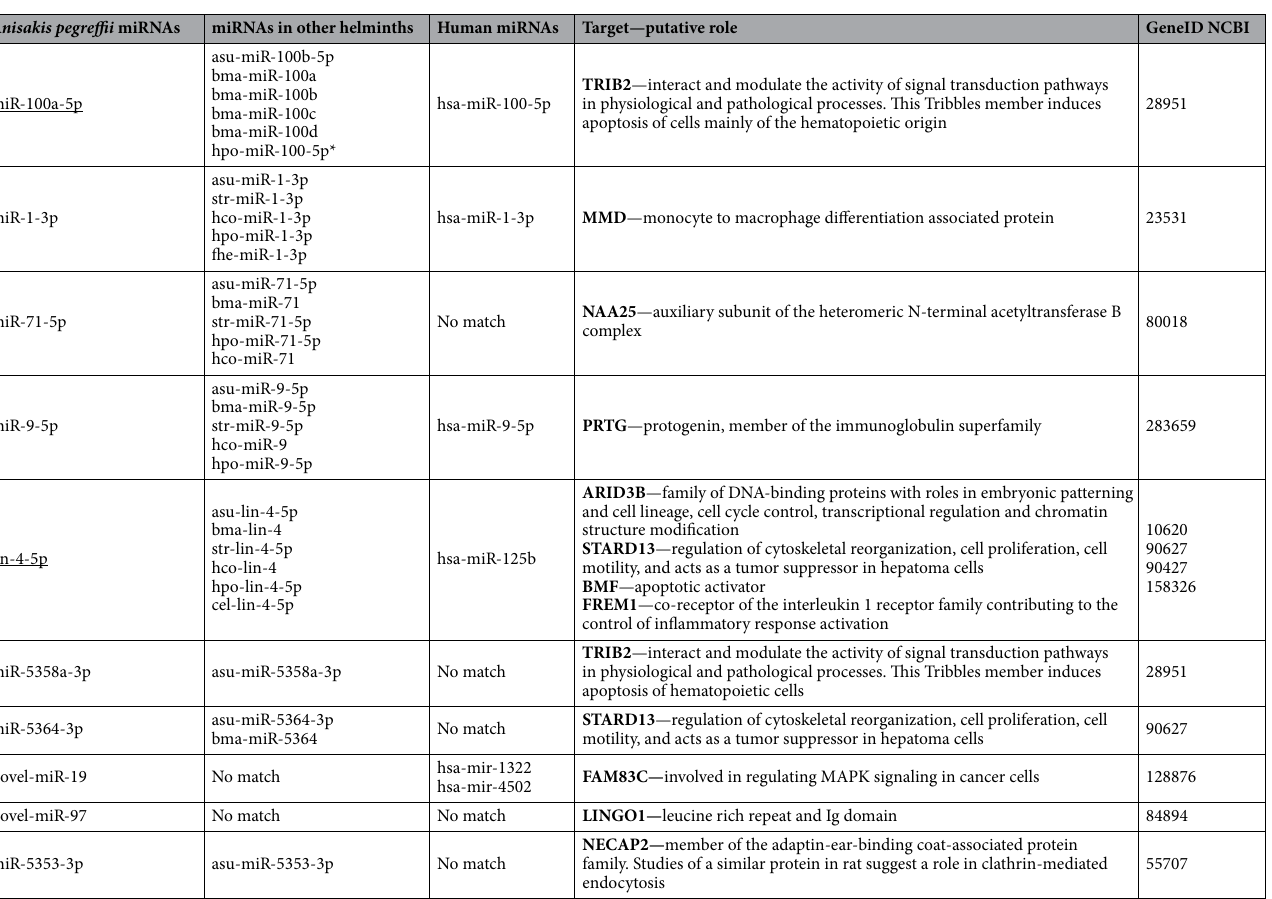
Table 4. List of ten selected Anisakis pegreffii abundant miRNAs in larvae and in extracellular vesicles, together with putative orthologues miRNAs from other parasitic helminths with conserved seed region, and human miRNAs putative orthologues. The last two columns include Anisakis pegreffii miRNAs predictive targets in human genome according to miRDB and their ID according to NCBI database. Asterisks indicate a miRNAs enriched in exosomes, according to literature. (Underlined miRNAs are abundant both in L3 and in EVs